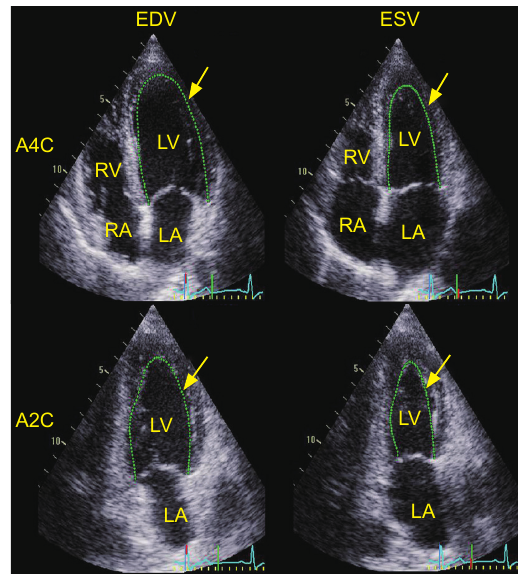
Figure 1 Automated measurements of LVEF and volumes. Examples of left ventricular endocardial tracing by automated measurement, and area under the green line is the region of interest (ROI) of left ventricular (yellow arrow). A4C, apical four-chamber; A2C, apical two-chamber; RV, right ventricular; RA, right atrial; LV, left ventricular; LA, left atrial.